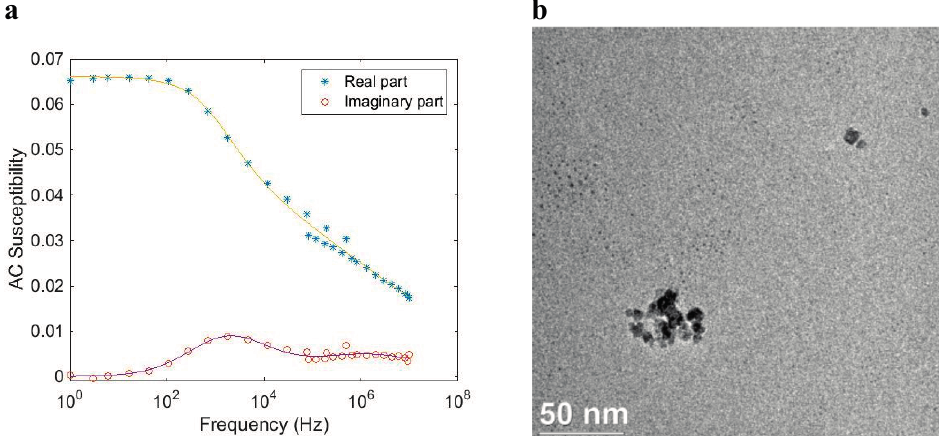
Figure 11. ( a ) AC susceptibility vs. frequency at room temperature of a magnetic nanoparticle system ( NPG3311 ) that exhibits a mixture of Brownian and Néel